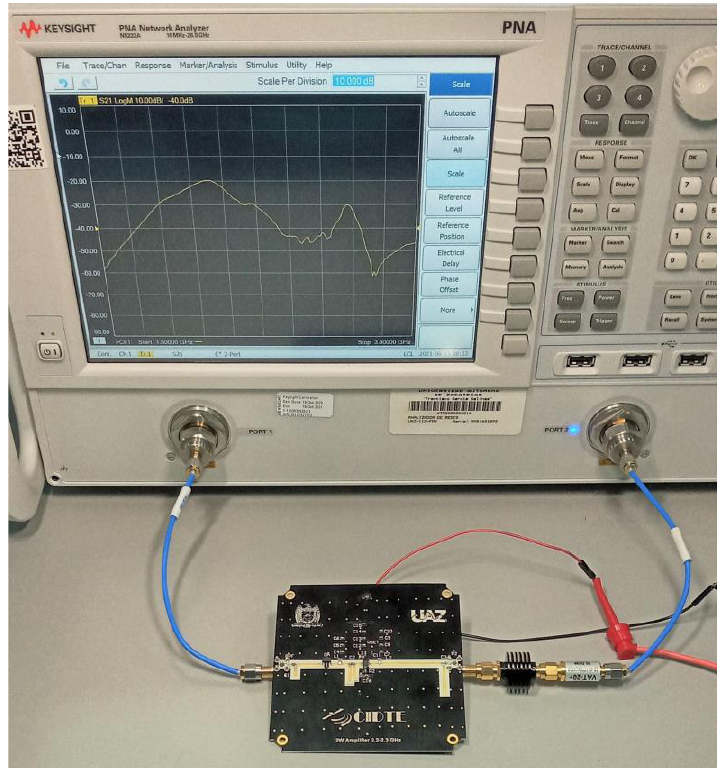
Figure 5. Setup for measuring the transmission parameter (S 21 ) by using a vector network analyzer (VNA).